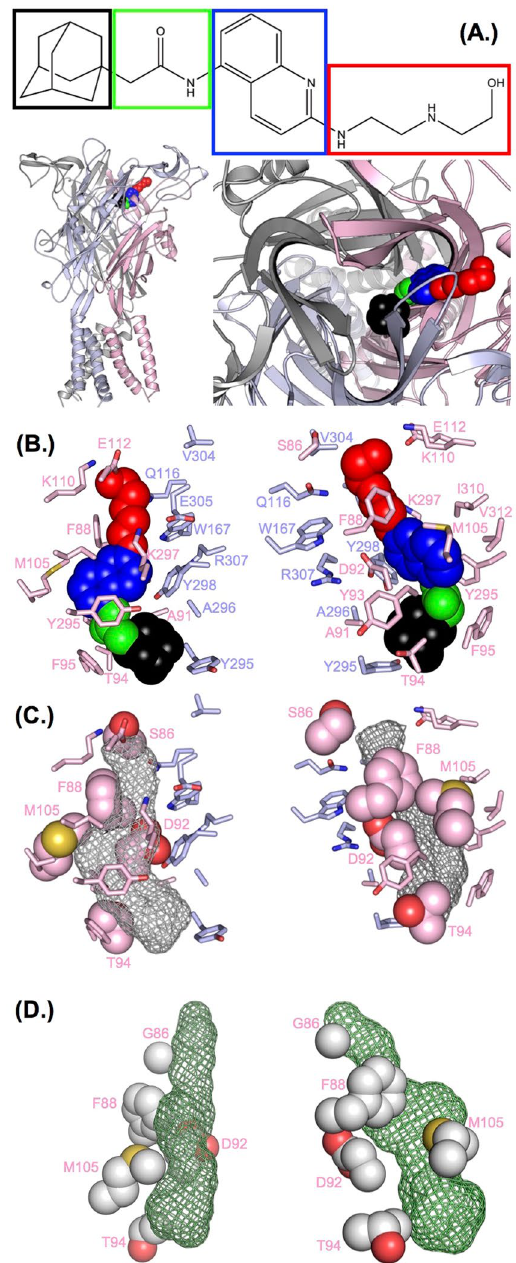
Figure 6. Comparison of docking of AZ10606120 into the allosteric pocket of the hP2X7R homology model and the panda P2X7R X-ray structure. ( A ) Top: Structure of AZ10606120. Regions referred to as adamantane, linker, aromatic and tail in the text are surrounded by black, green, blue and red boxes, respectively. This colour scheme is also used for AZ10606120 in the remaining panels of ( A ) and in ( B ). Bottom: The AZ10606120 docking pose in best agreement with experimental data is shown in an overview from a view parallel to the membrane (left), and in zoom perpendicular to the membrane (right). Light blue, light red and grey colours indicate different subunits. ( B ) P2X7R residues in proximity of AZ10606120 for the docking pose as in ( A ) are shown as sticks (side chain only) in two complementary views. Both views are derived by rotation from ( A ) bottom right. The colour scheme is as described in ( A ). ( C ) Residues for which mutation had the biggest effect on AZ10606120 inhibition are shown as spheres and labelled. The shape of AZ10606120 is indicated as grey mesh, both views are as in ( B ). ( D ) hP2X7R mutations that had the biggest effect on AZ10606120 inhibition were mapped on the P2X7R/AZ10606120 X-ray structure (PDB-entry: 5U1W (24)) and shown as spheres, AZ10606120 is represented as green mesh. Residue S86 in hP2X7R is equivalent to G86 in the panda P2X7R. Views in register as for ( B ) and ( C